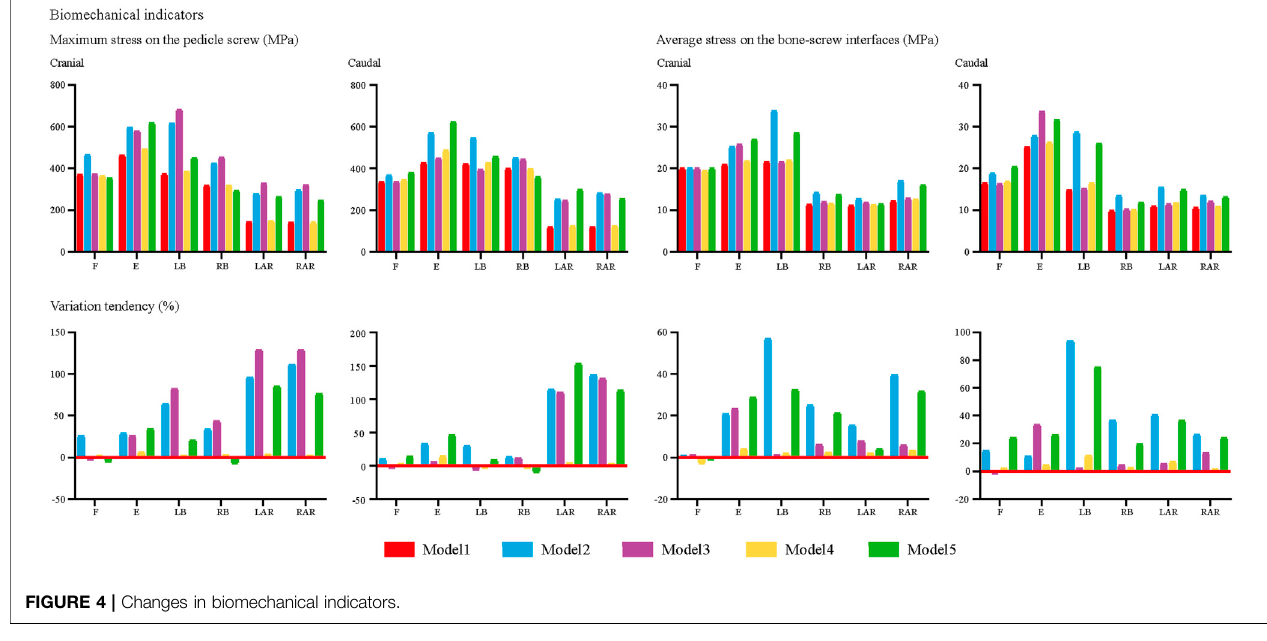
FIGURE 4 | Changes in biomechanical indicators.